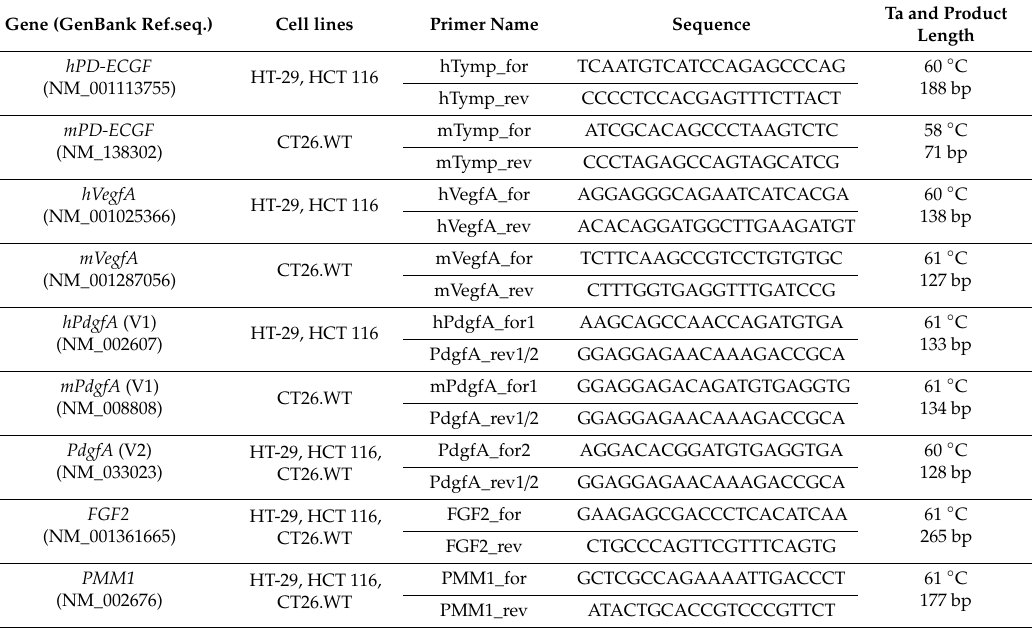
Table 1. Nucleotide sequences of primers used for RT-qPCR. Gene (GenBank